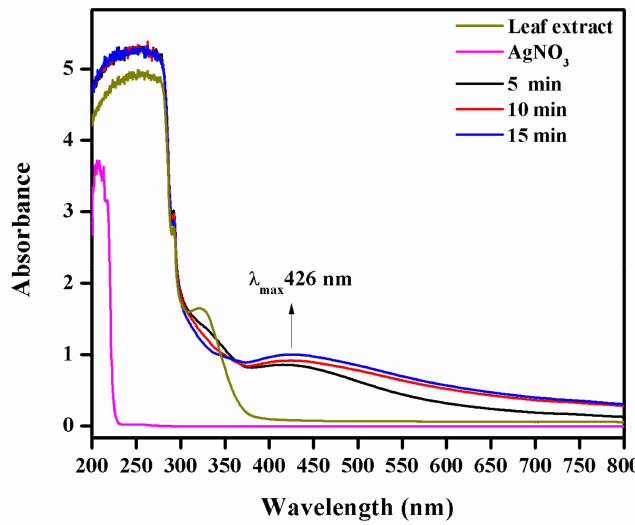
Figure 2. Ultraviolet visible (UV-vis) analysis of Ag nanoparticles (NPs).